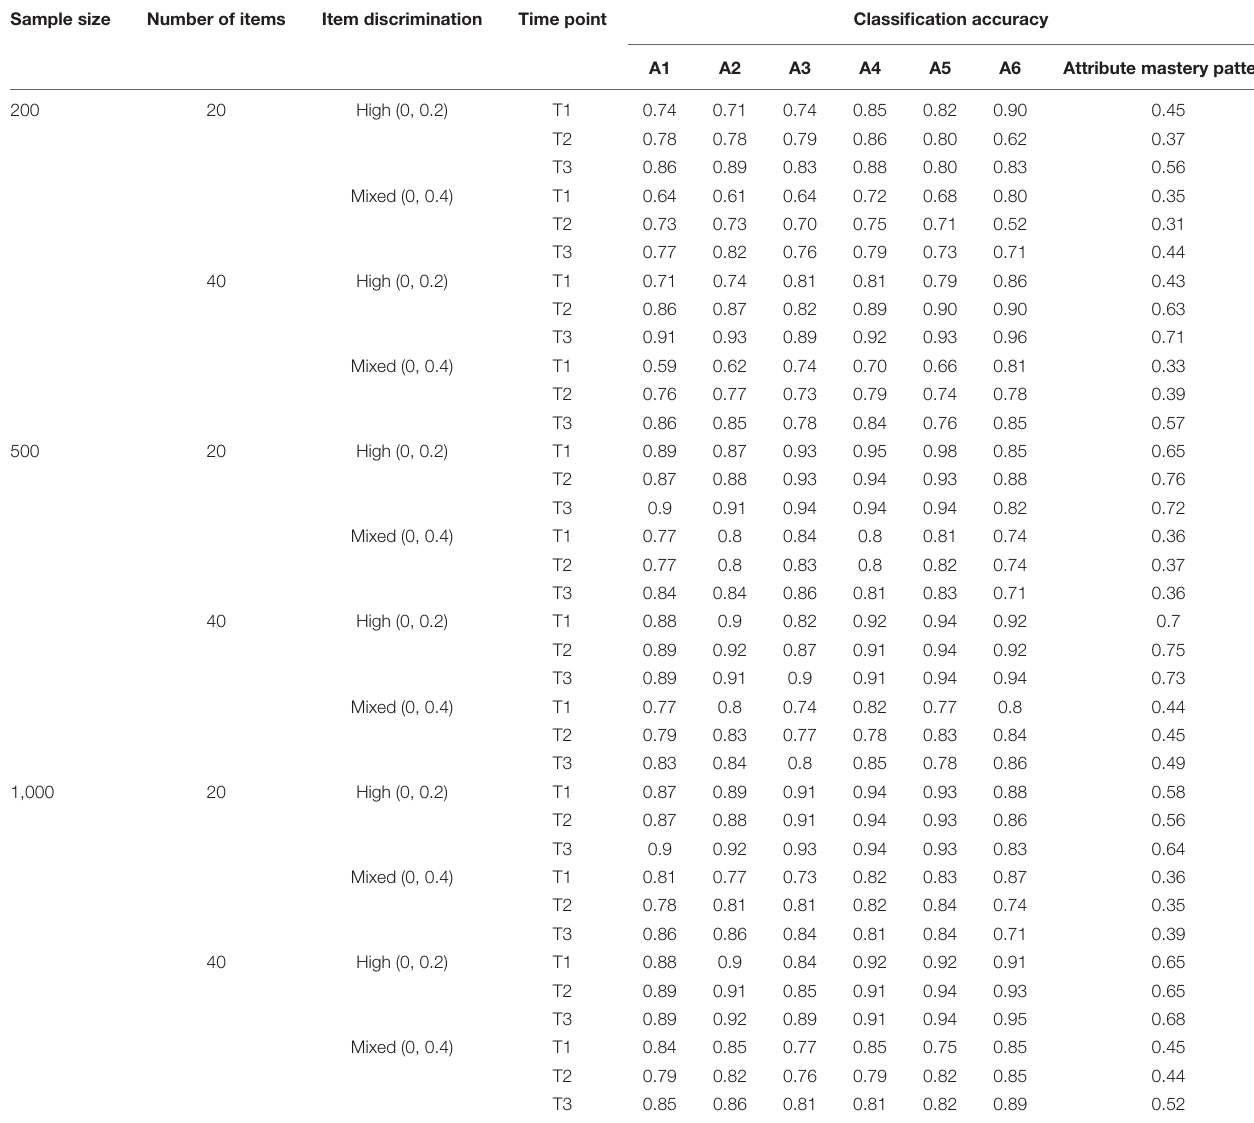
TABLE 5 | Attribute classification accuracy ( k = 6). Sample